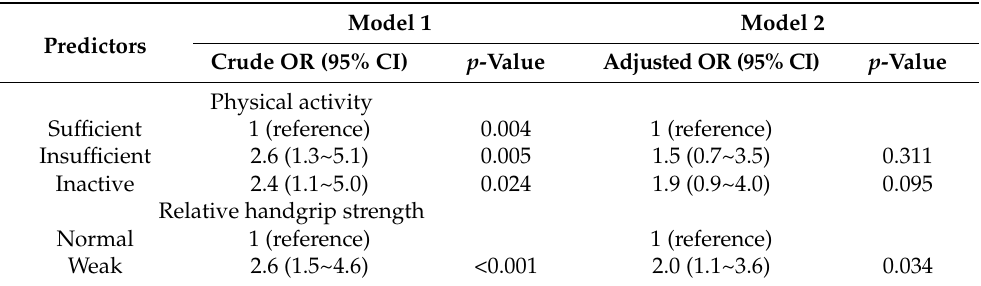
Table 3. Odds ratios (ORs) and 95% confidence intervals (CIs) of low health-related quality of life according to levels of physical activity and relative handgrip strength.